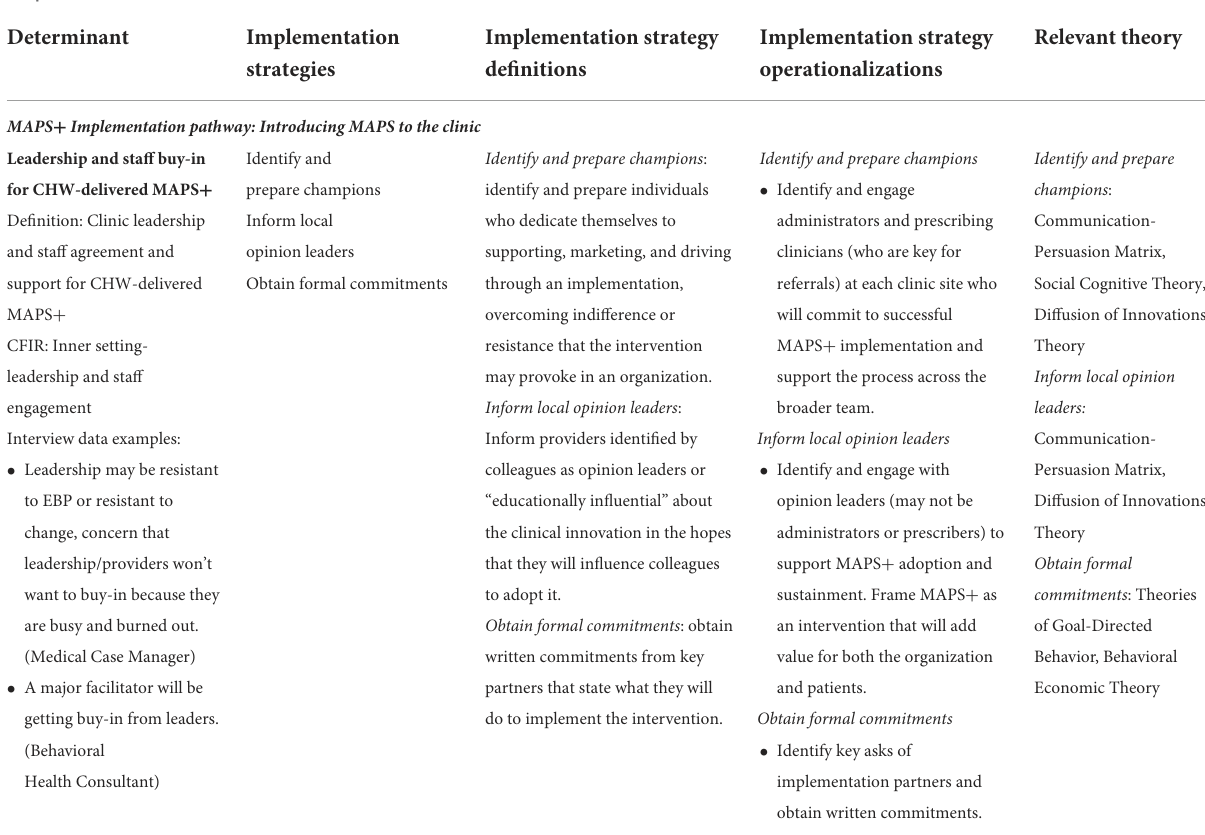
TABLE 1 Example of identified determinant, strategies, definitions, operationalizations, and relevant theory per the implementation menu (Step 4